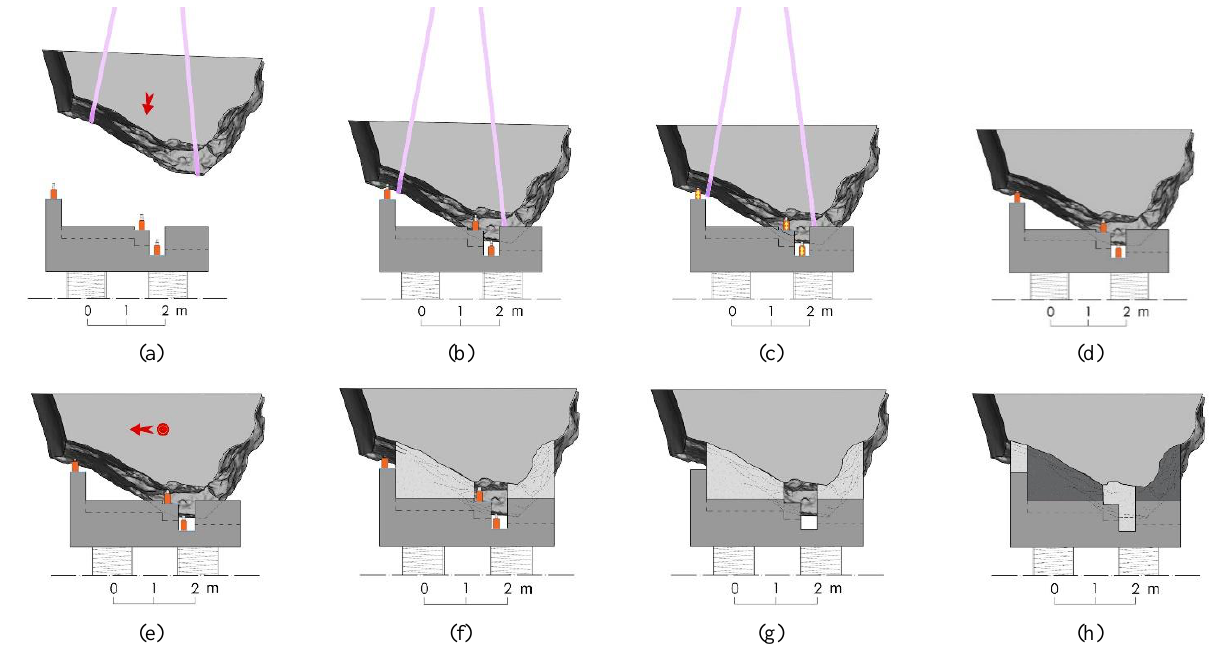
Figure 11: The steps of the assembly, (a) lifting, (b)placing on three lifting jacks, (c) levelling, (d) detachment of the crane’s straps,